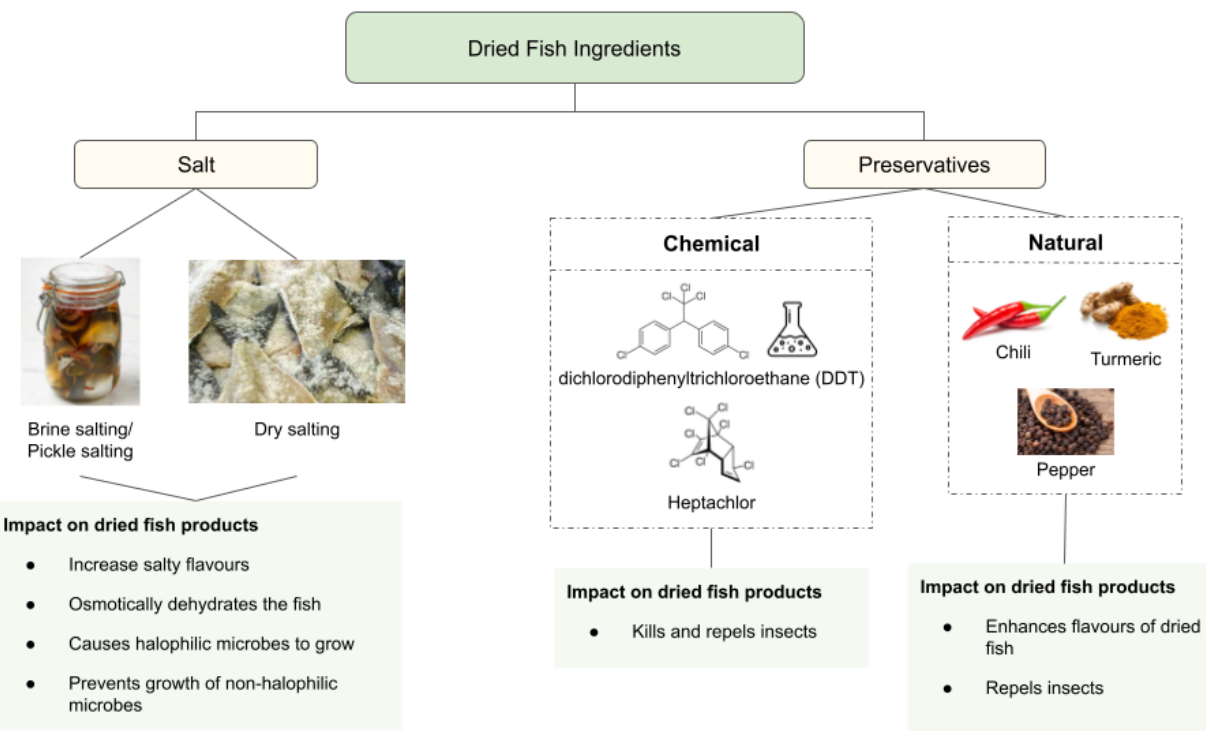
Figure 3. Ingredients in dried fish products and their effects on dried fish.